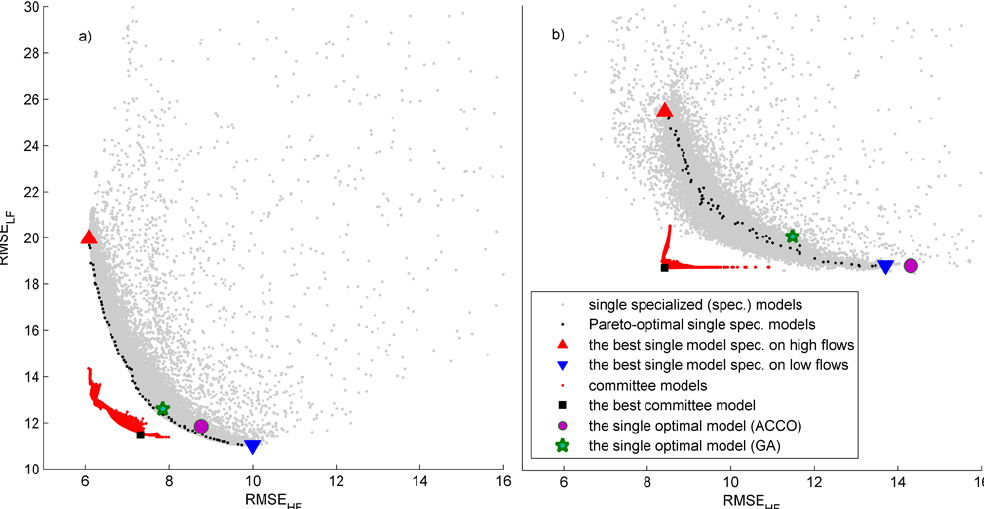
Fig. 3. The identified sets of Pareto-optimal parameterizations of single specialized models (optimized by NSGA-II), committee models and single optimal models, calibrated by ACCO and GA in Leaf catchment: (a) calibration data set and (b) verification data set (model parameterizations from (a) are